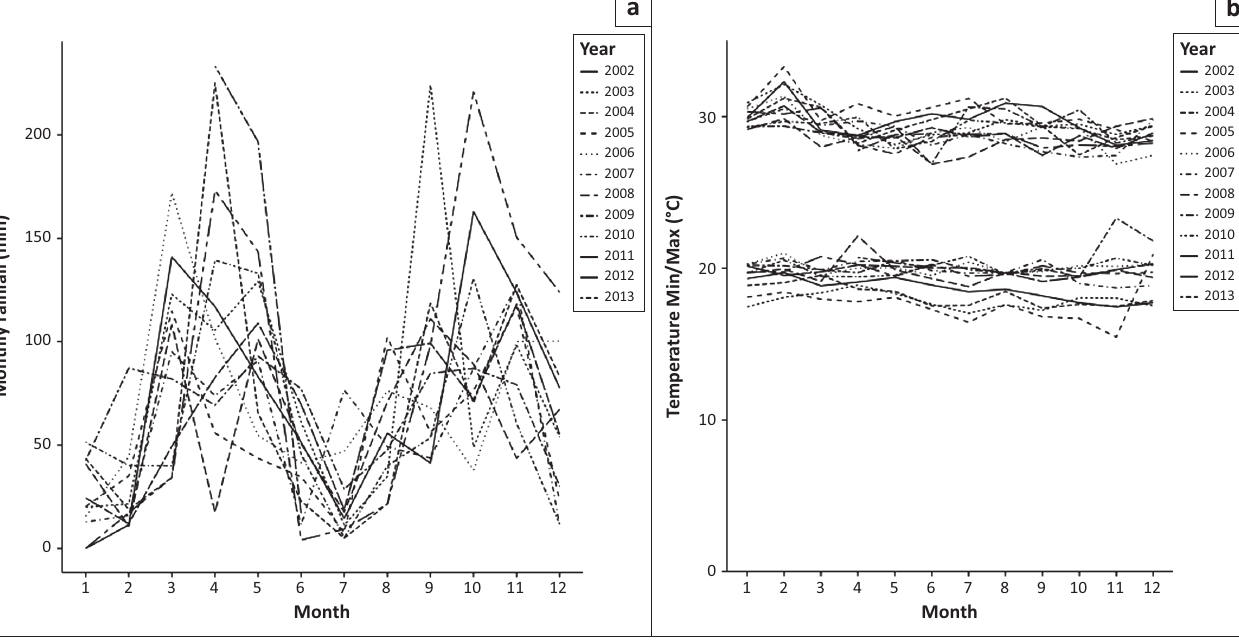
FIGURE 5: (a) Monthly rainfall and (b) mean monthly min–max temperature at Uganda Wildlife Authority Mweya weather station in Queen Elizabeth National Park for 2002–2013.